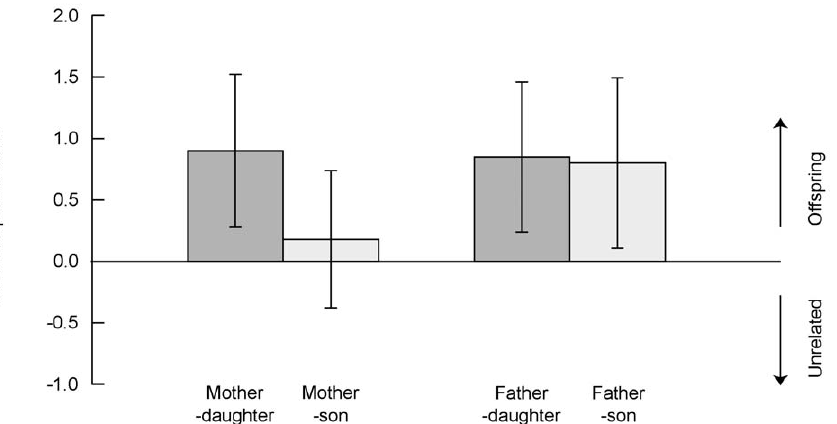
Figure 3. Performance on kin discrimination trials. Mean (and SD) resemblance scores between offspring versus unrelated individuals and the target image (parent), as a function of relatedness type (paternal, maternal) and the subject’s level of previous experience with nonhuman primates. A mean of zero represents chance performance. Positive values indicate that the offspring image was rated as being more similar to the parental target than was the unrelated individual, with higher values indicating a greater disparity in perceived